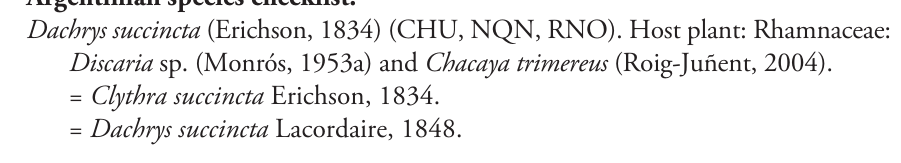
Figure 6. Cylindrodachrys cleroides Monrós (2) , left: habitus (dorsal view), right: habitus (lateral view). Argentinian species